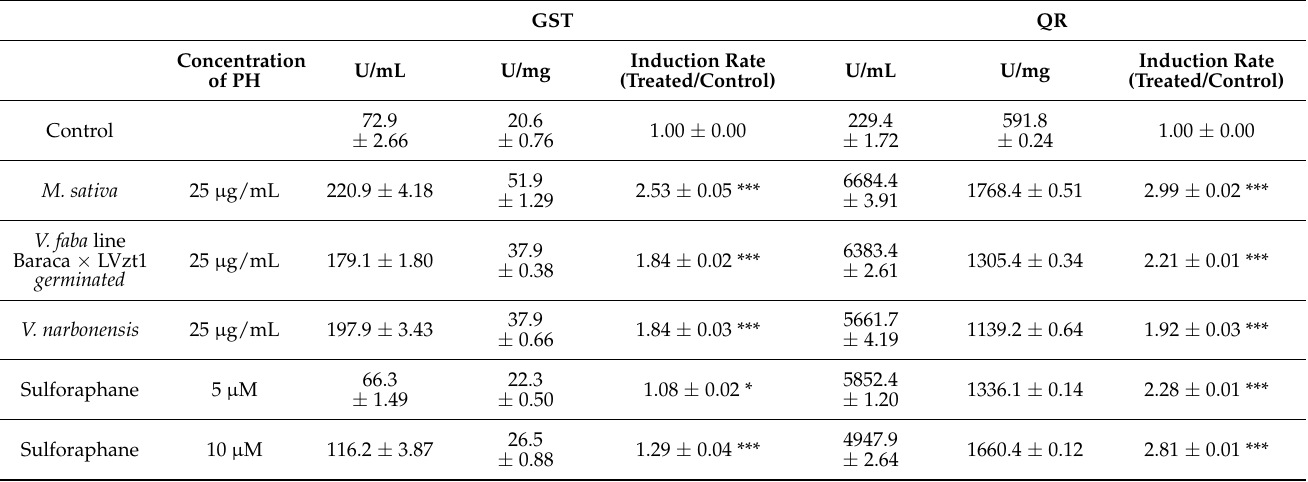
Table 7. GST and QR induction activity on the HT-29 cells after treatment with protein